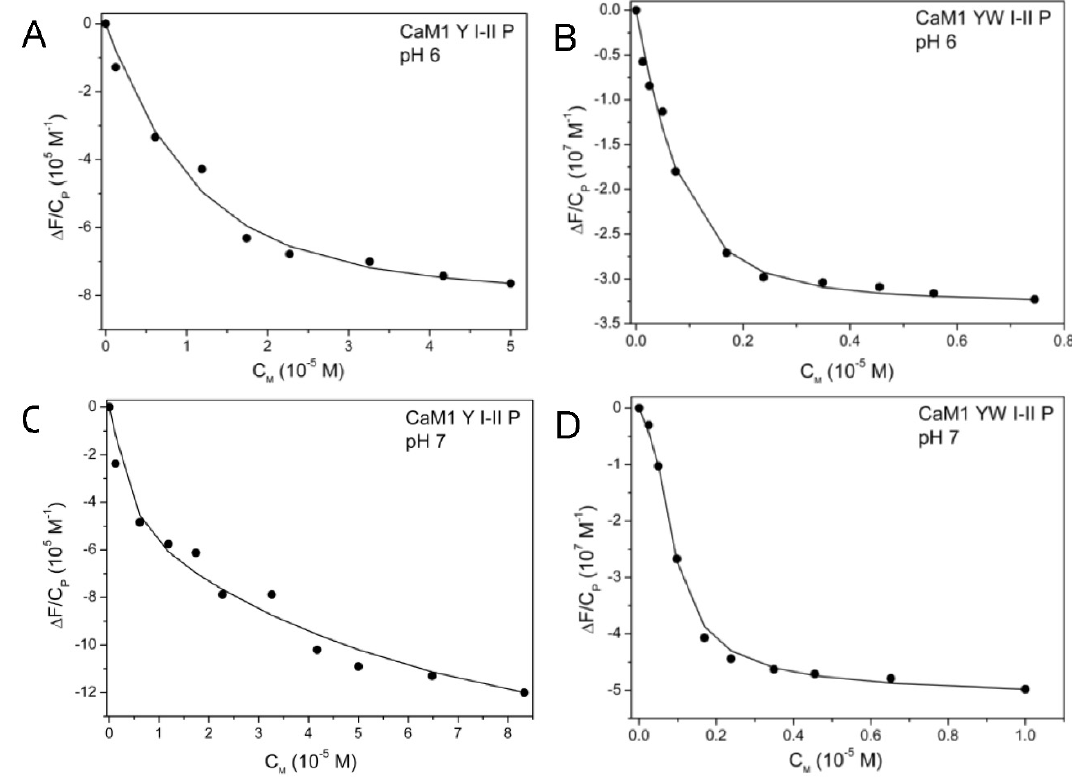
Figure 4. Fluorescence binding isotherms for the interaction of UO 22+ ion with the phosphorylated two-site peptides CaM1 Y I-II P (at λ = 302 nm) at pH 6 ( A ) and pH 7 ( C ) and CaM1 YW I-II P (at λ = 350 nm) at pH 6 ( B ) and at pH 7 ( D ). Initial C P = 5.10 − 6 M, initial C I = 5.10 − 4 M for CaM1 Y I-II P, initial C P = 5.10 − 7 M, initial C I = 5.10 − 5 M for CaM1 YW I-II P. T = 298 K. Experimental data (dots) and adjustment (black solid line), according to Equation (4).